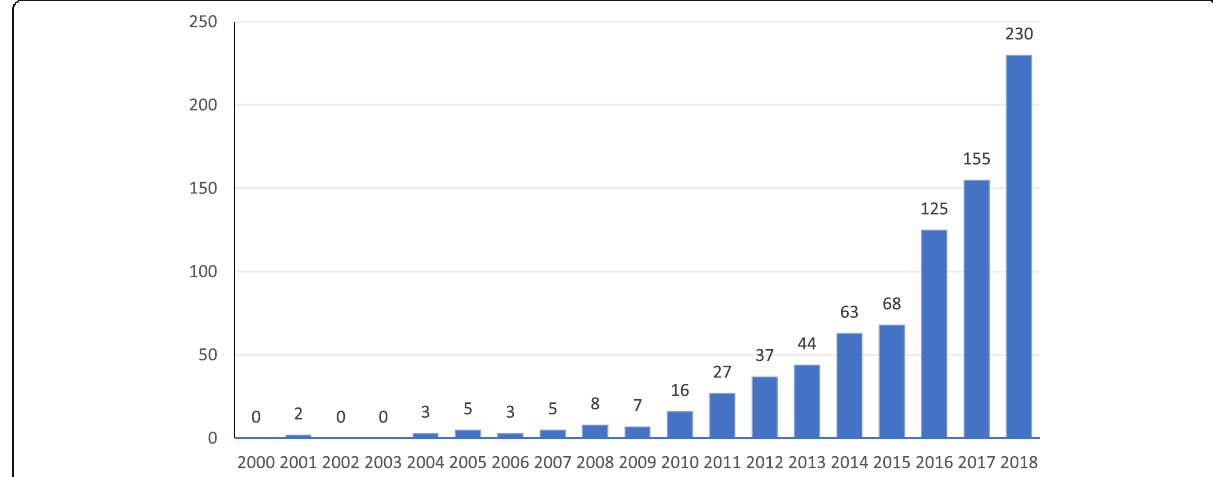
Fig. 1 The distribution of STEM education publications over the years